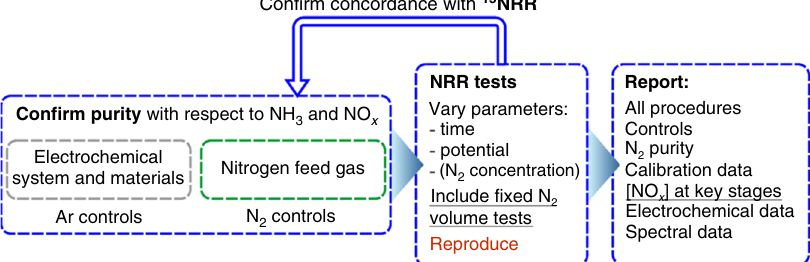
Fig. 4 Updated and simpli fi ed NRR experimental protocol. Tests with a fi xed and/or low volume of the N 2 gas are recommended, as is the quanti fi cation of NO x at every key step. Demonstration of the NRR as a function of time and potential is critical, while studies aiming at thorough kinetic analysis should also investigate the effect of N 2 concentration (which can be either decreased or increased with respect to the experiments at 1 atm). More detailed explanation of each key stage has been reported previously by us 8,25 and others 7,9